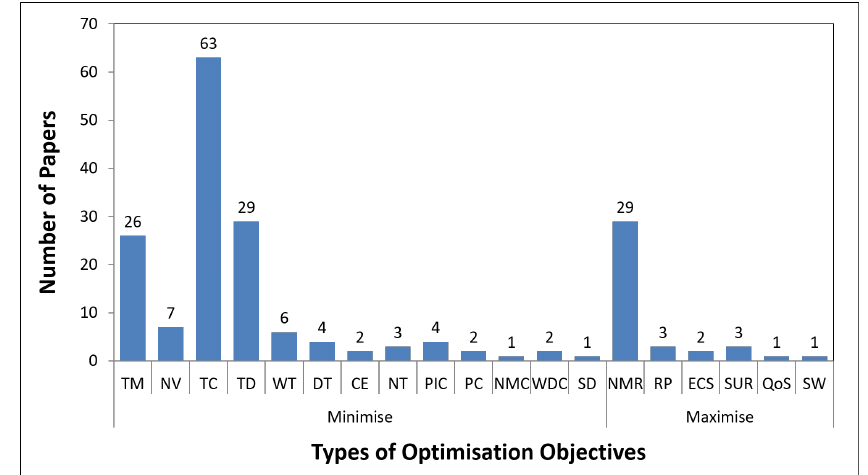
Figure 12. Distribution of Papers based on the Optimisation